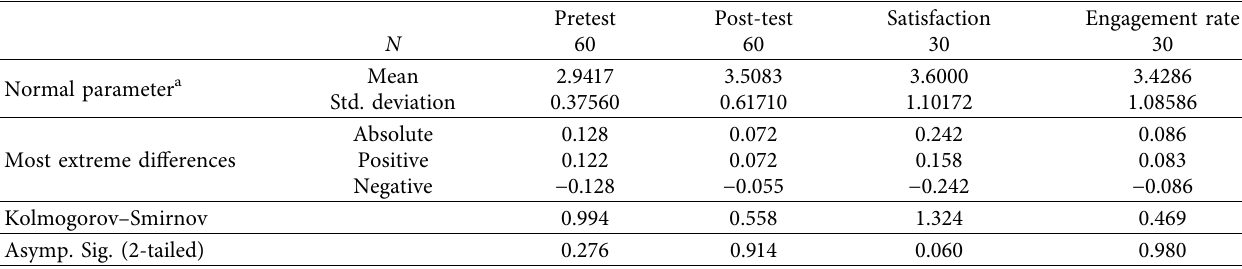
Table 2: Kolmogorov–Smirnov test of the research variable.